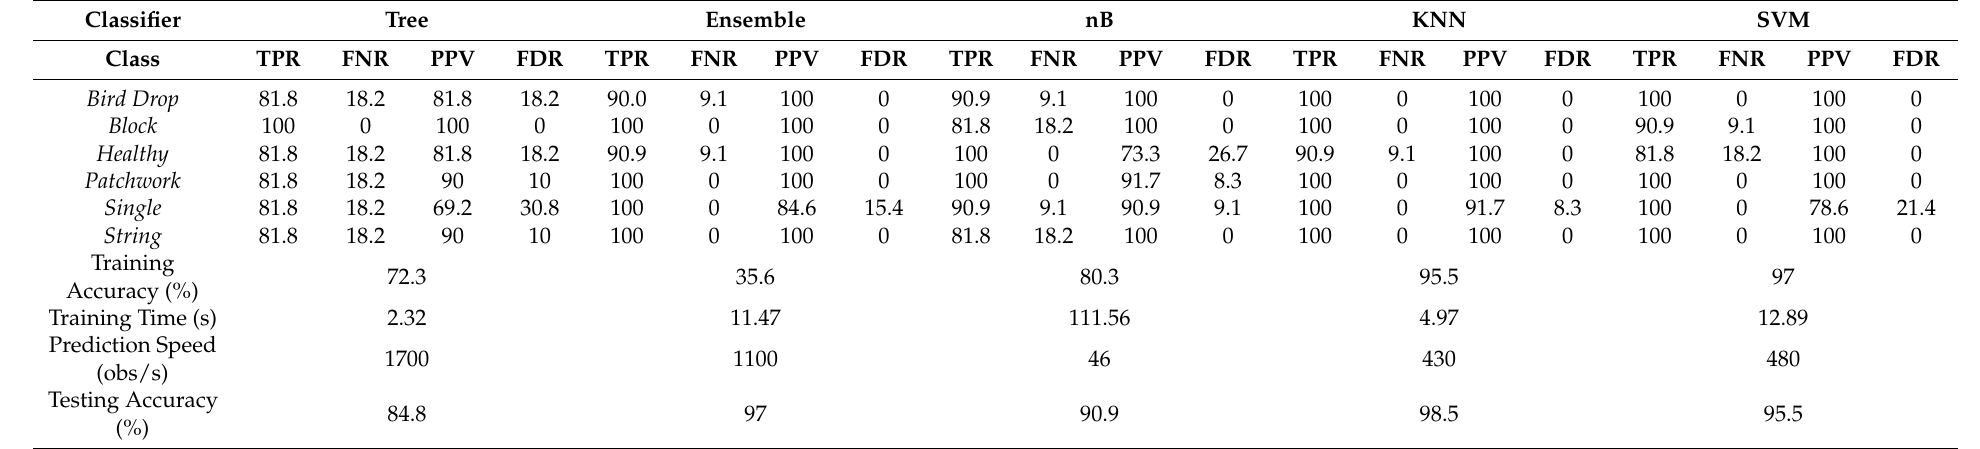
Table 5. ResNet18-based features calculation and shallow